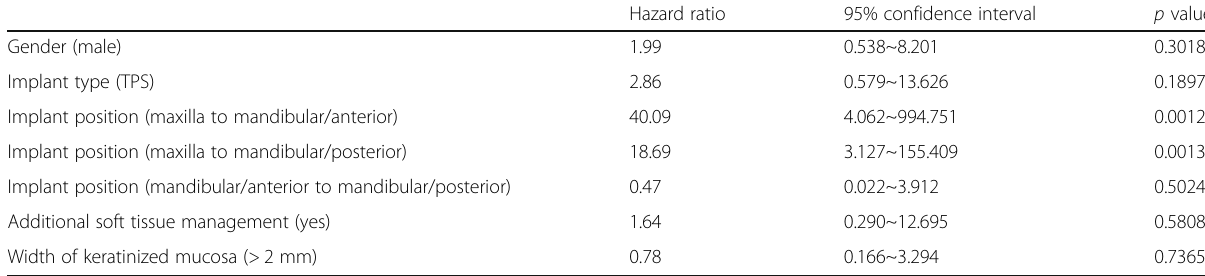
Table 5 Cox regression analyses for implant